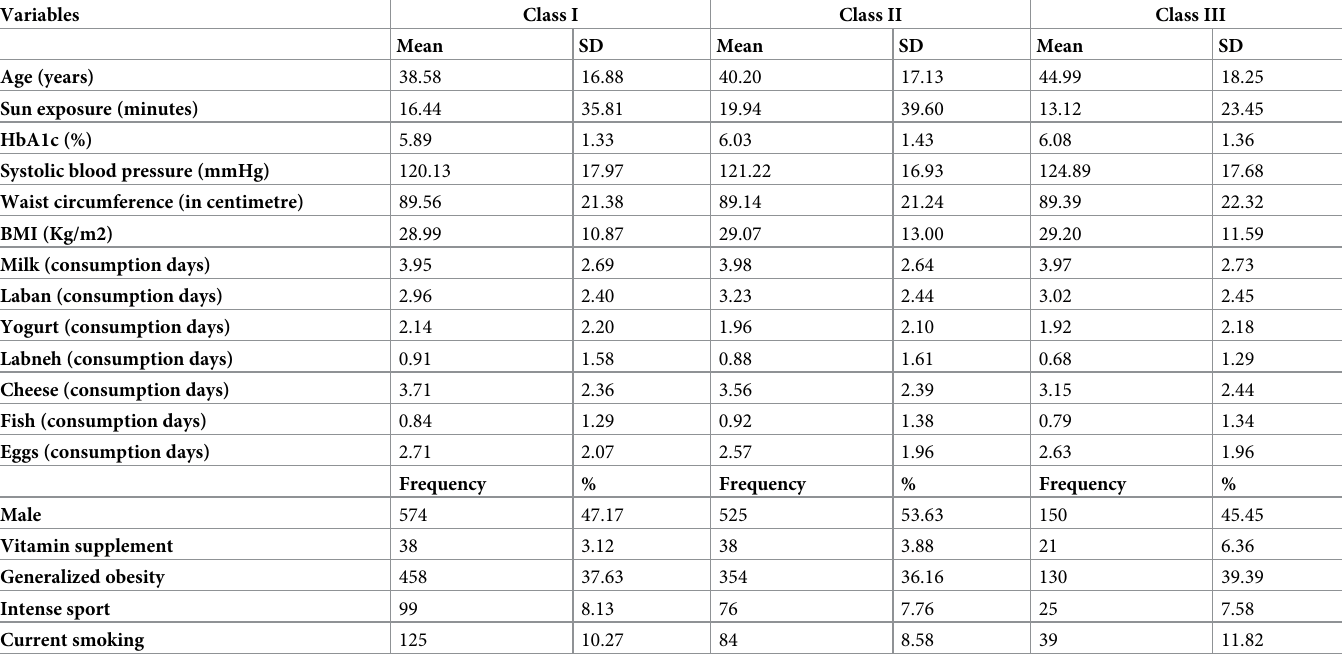
Table 3. Descriptive statistics of posterior probability for 3 components